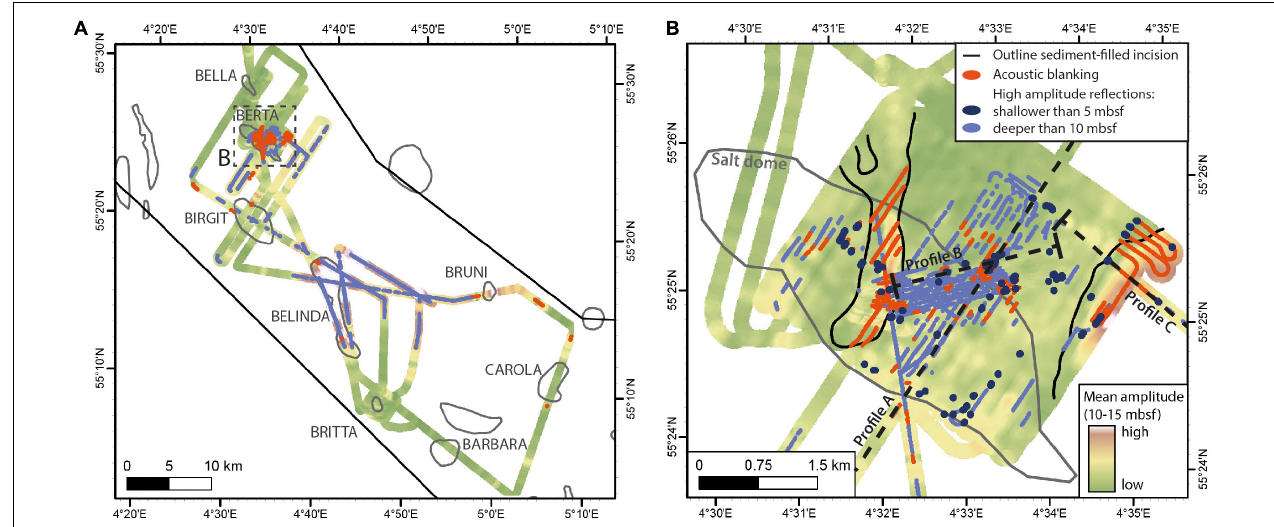
FIGURE 6 | Subbottom analysis maps showing mean amplitude values between 10 and 15 mbsf throughout the entire dataset acquired, the locations of high-amplitude reflections (blue) and acoustic blanking (red). (A) Overview map (interpolated raster surface from track points using kriging, grid cell size is 50 m and maximum point distance is 500 m), (B) detailed map of the area mapped at salt diapir Berta (interpolated raster surface from track points using kriging, grid cell size is 10 m and maximum point distance is 100 m).